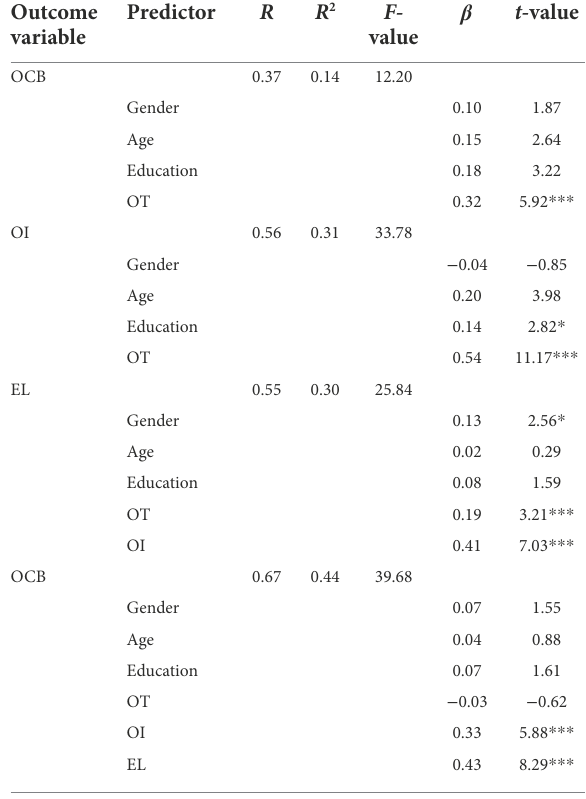
TABLE 4 Regression analysis.